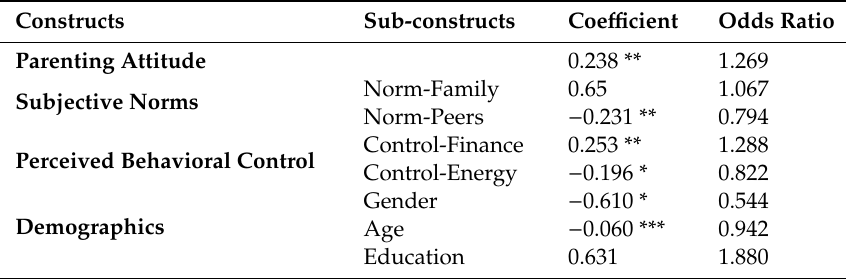
Table 6. The logistic regression on fertility intention.